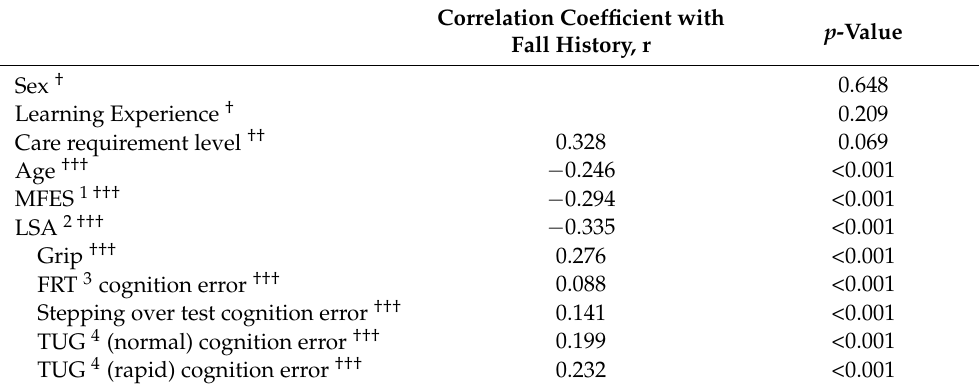
Table 3. Correlation with fall history for each